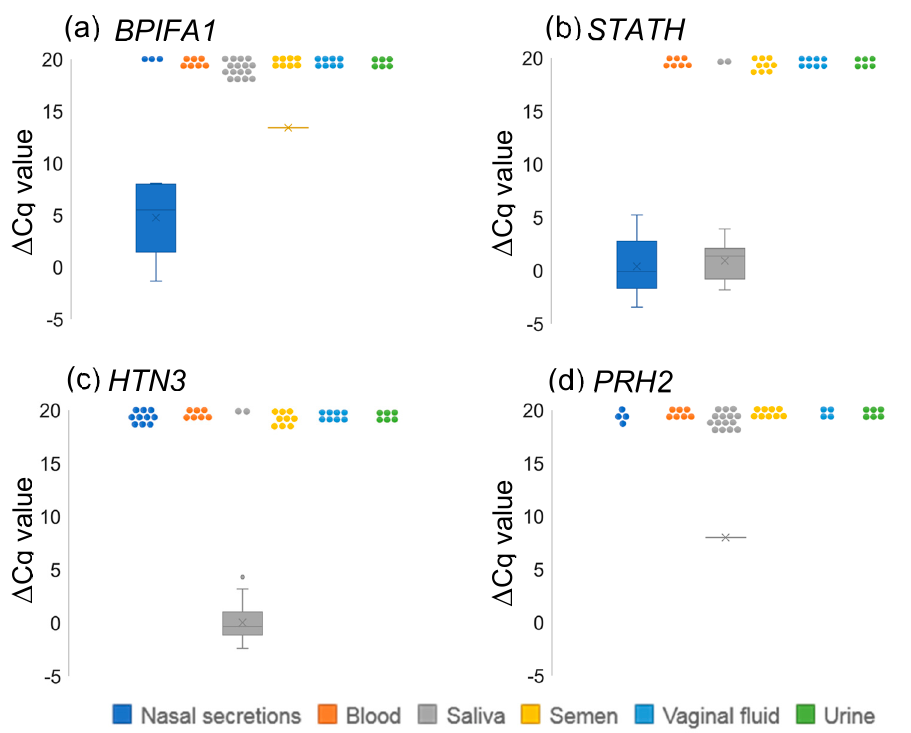
Figure 1. Box plots showing expression levels of BPIFA1 ( a ), STATH ( b ), HTN3 ( c ), and PRH2 ( d ) in various body fluids. Each dot at around ∆ Cq = 20 represents samples that show no amplification or are outside of the linear range.